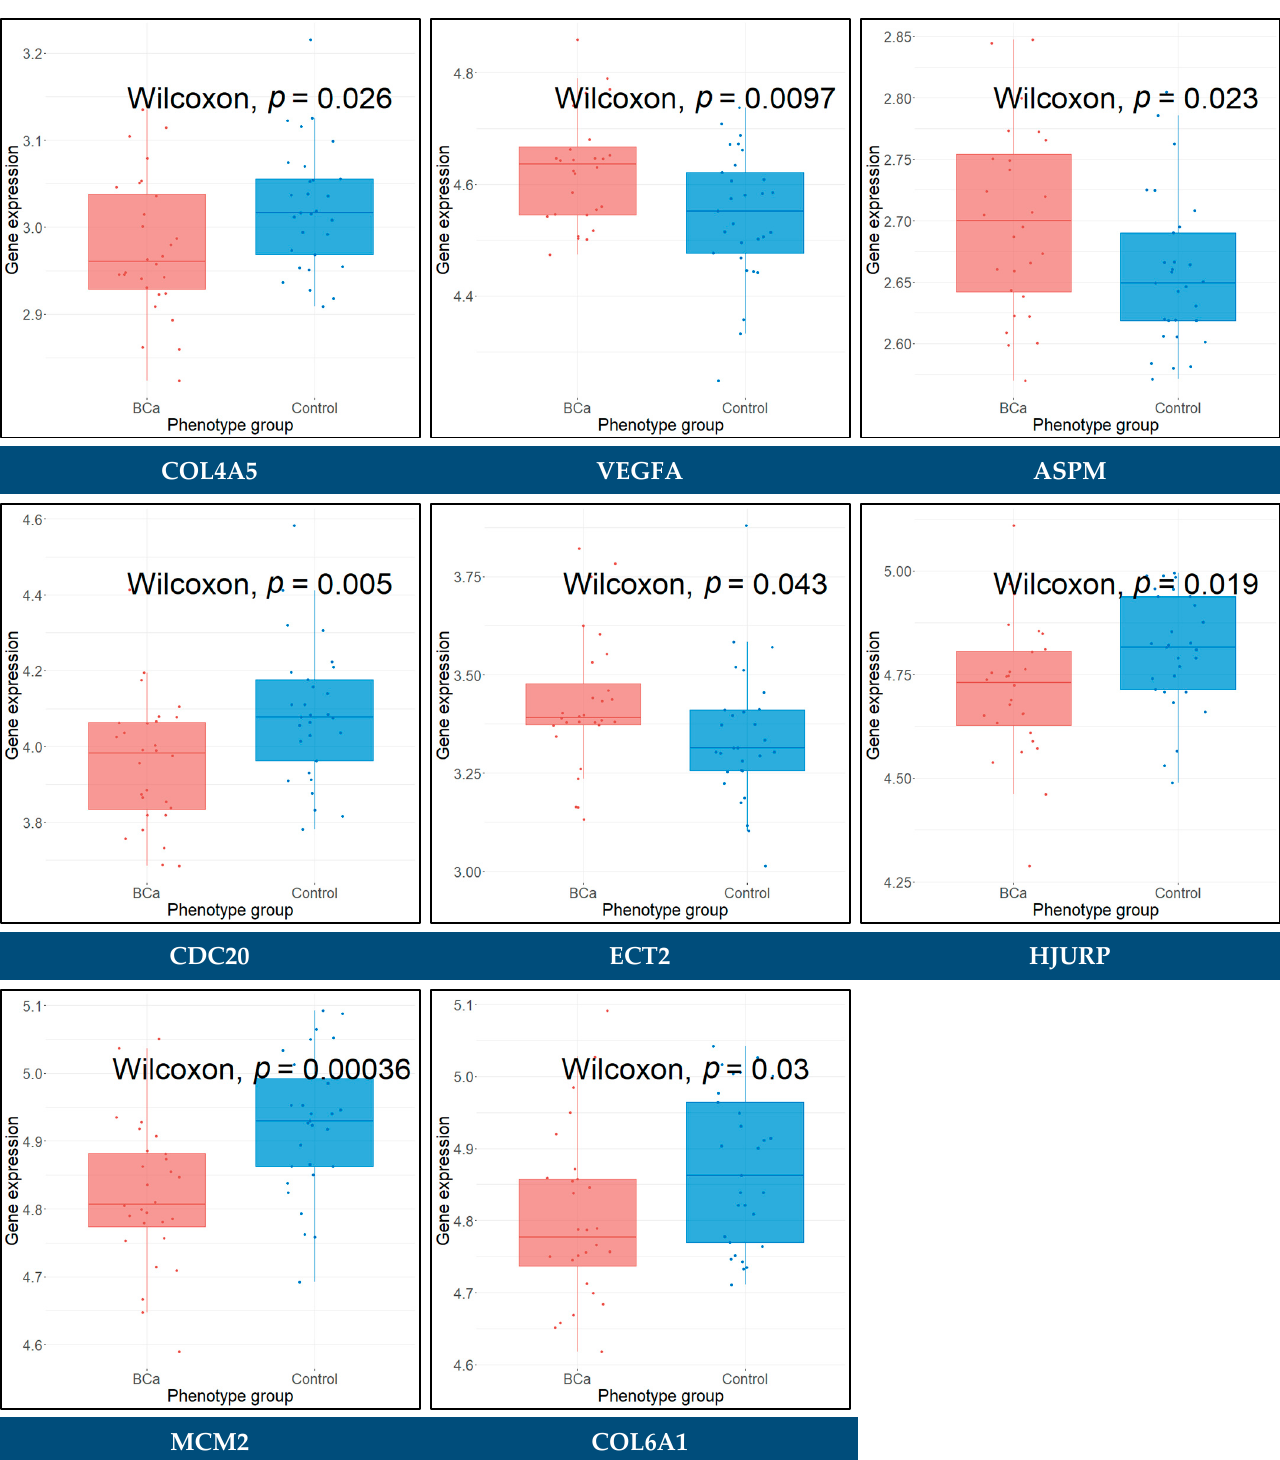
Figure 13. Significantly differentially expressed key hub genes in blood plasma samples using the Wilcoxon rank sum test in GSE138118 ( n = 57). Wilcoxon rank sum test in GSE138118 ( n =